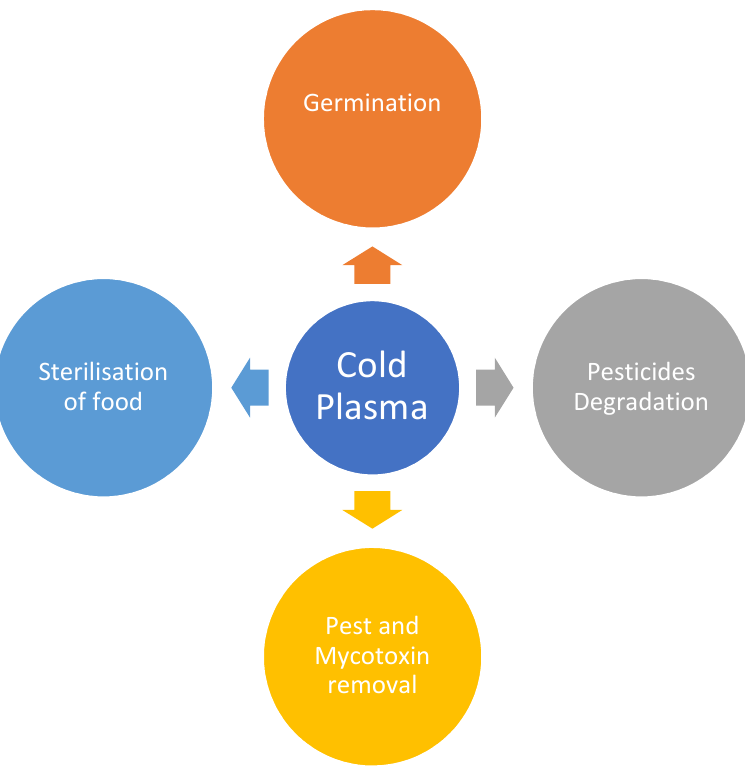
Figure 2. Cold plasma technology is used in various stages of food production.